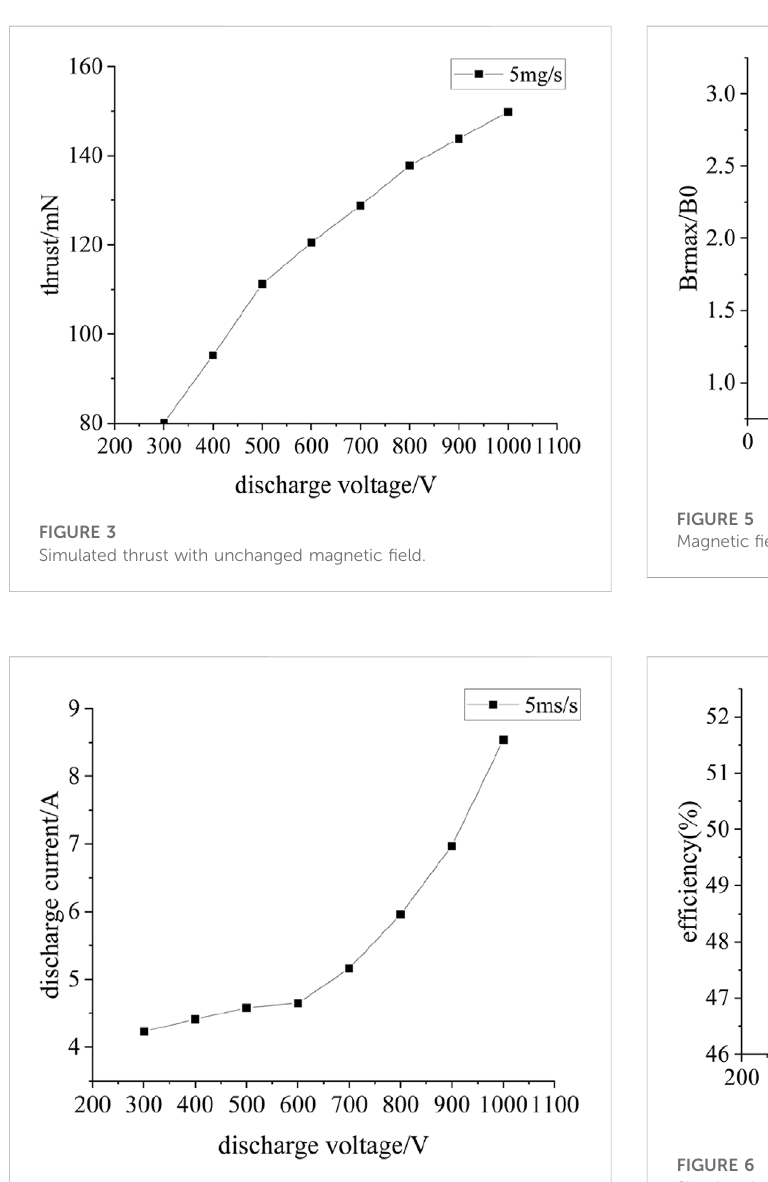
FIGURE 4 Simulated discharge current with unchanged magnetic fi eld.